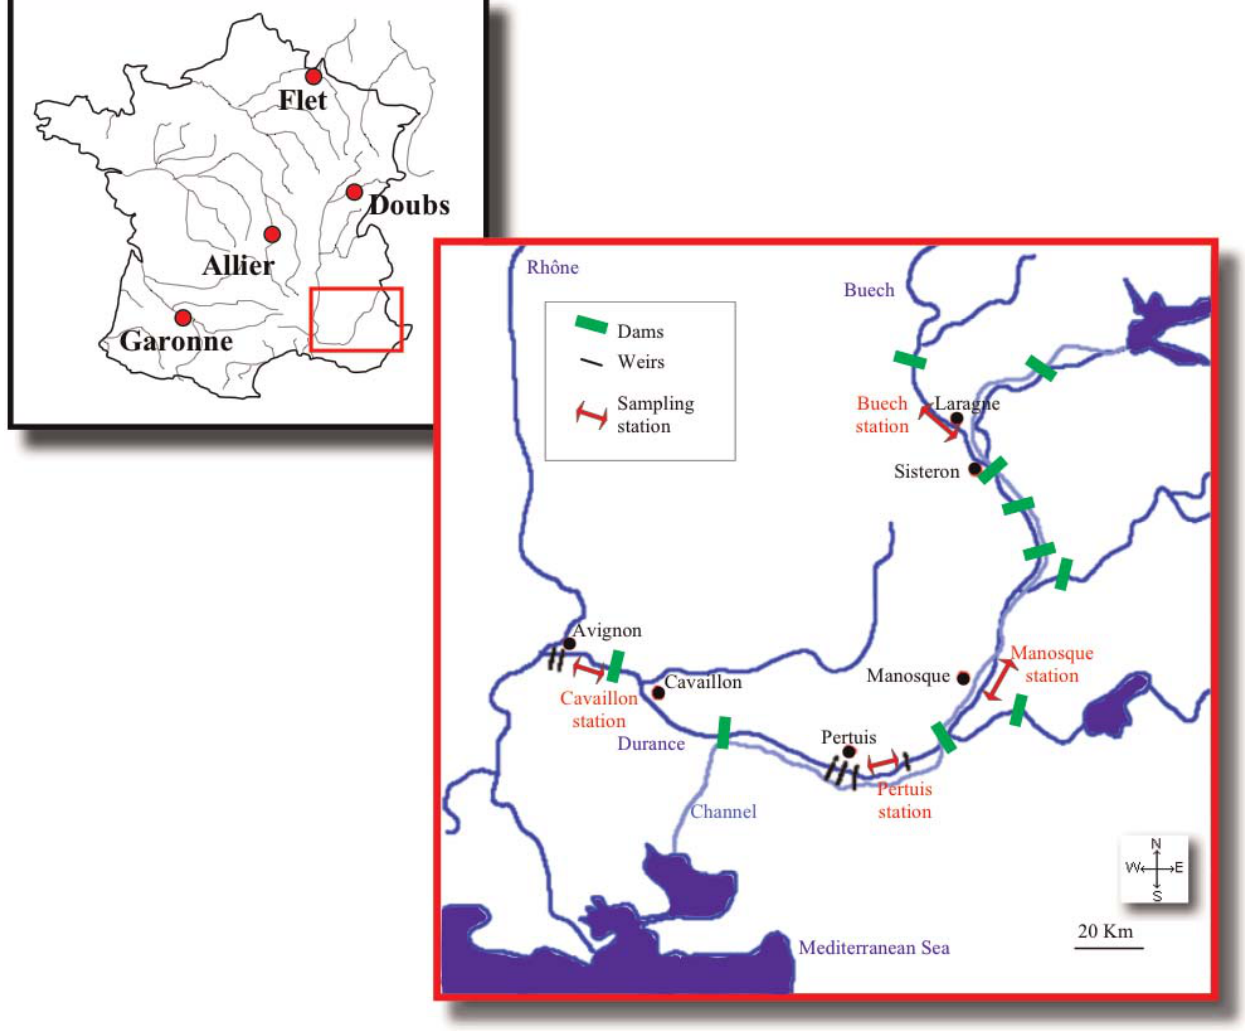
Figure 9. GEOGRAPHICAL AREA STUDIED. Allopatric zone: Garonne ( C. t. toxostoma ); Flet ( C. n. nasus ); parapatric zones: Doubs ( C. t. toxostoma ); Allier ( C. n. nasus ) and hybrid zone: the River Durance and the four sampling stations: Buech, Manosque, Pertuis and Cavaillon.